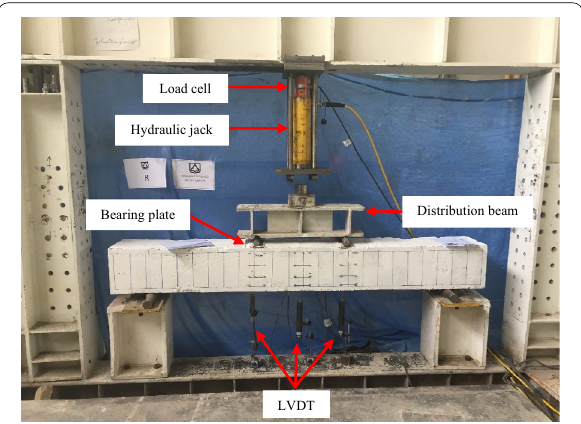
Fig. 7 A real view of test setup and